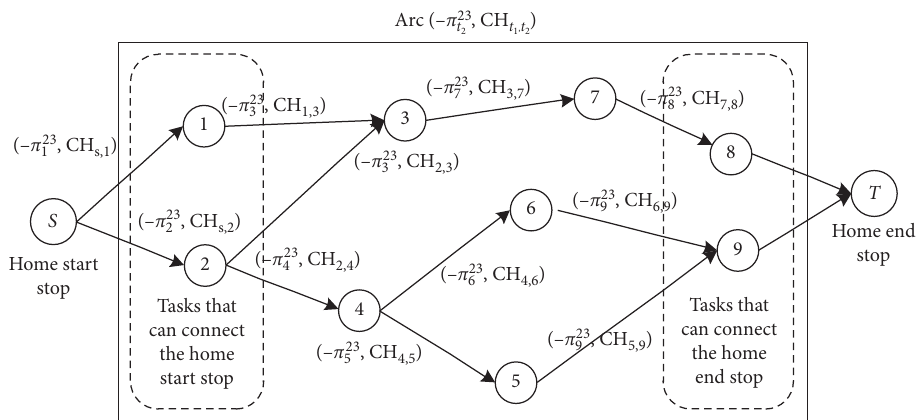
Figure 5: An illustrative network for the pricing